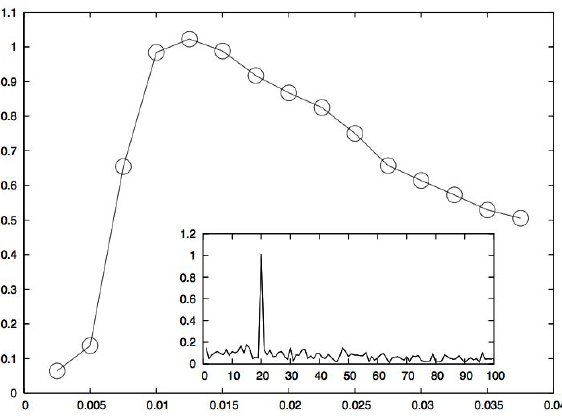
Fig. 5. The figure shows the Fourier amplitude | F X (ν = ω) | 2 for the solution of Eq. (7) for different values of the noise amplitude σ . In the inset we show | F X (ν) | 2 for σ = σ R , i.e. the optimal noise for which the Fourier amplitude at ν = ω is maximum.